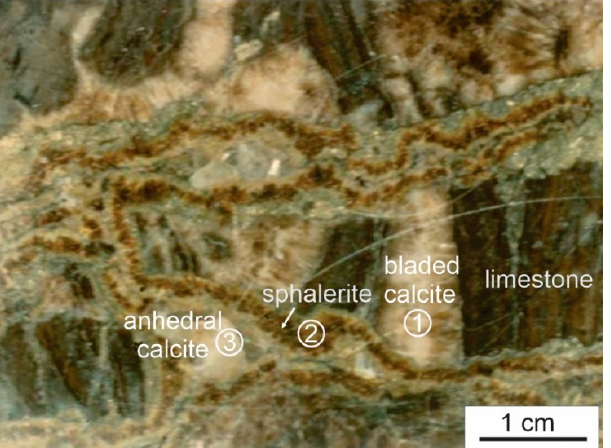
Figure 1. A hand sample showing three hydrothermal mineral phases representing different stages of the fluid system: pre-mineralization bladed calcite ① , syn-mineralization sphalerite ② , and post-mineralization anhedral calcite ③ . The sample is from the Jubilee carbonate-hosted Zn-Pb deposit, Nova Scotia, Canada.